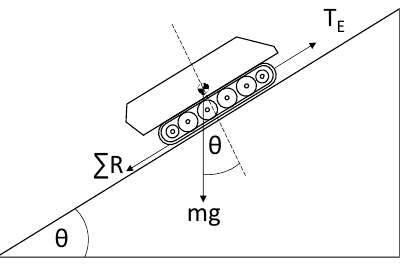
Figure 5. Force diagram of APC during normal operation.